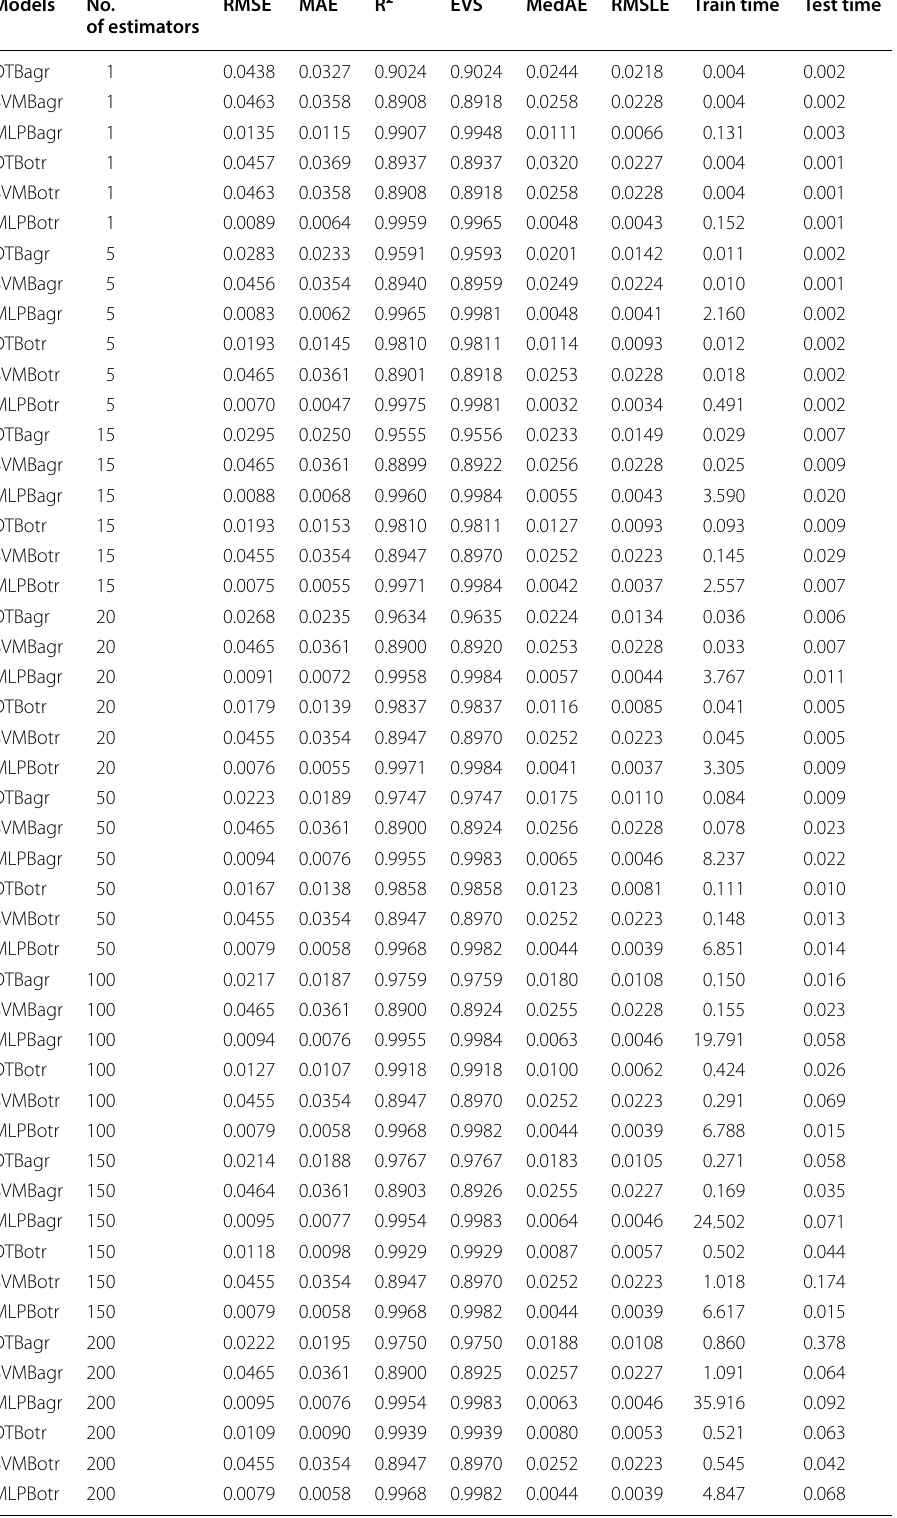
Table 15 Bagging and boosting ensemble regressors error metrics result over NYSE